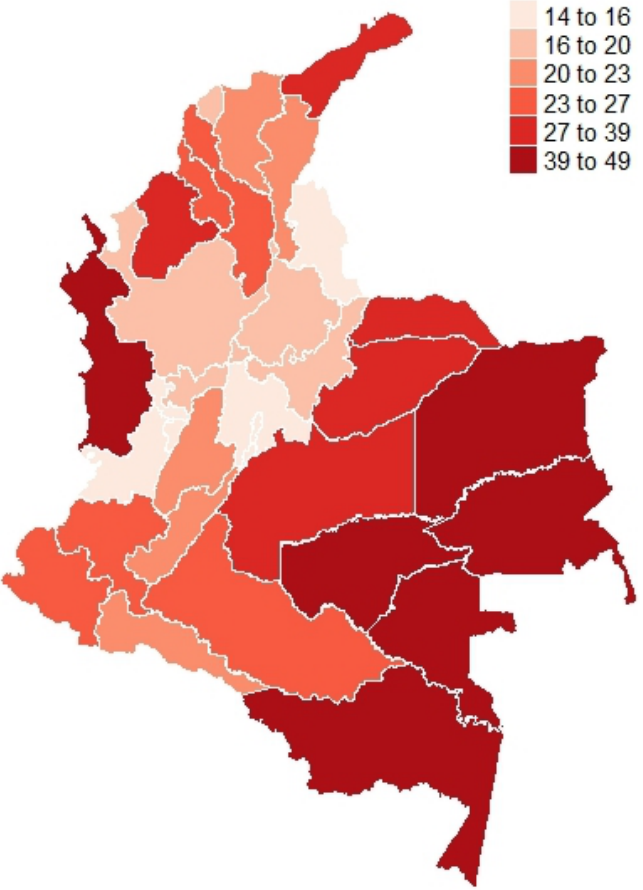
Figure 1. Spatial distribution of infant mortality rates in Colombia for the year 2005, by department, obtained as the number of children under one year of age who died in the year 2005 per 1000 born